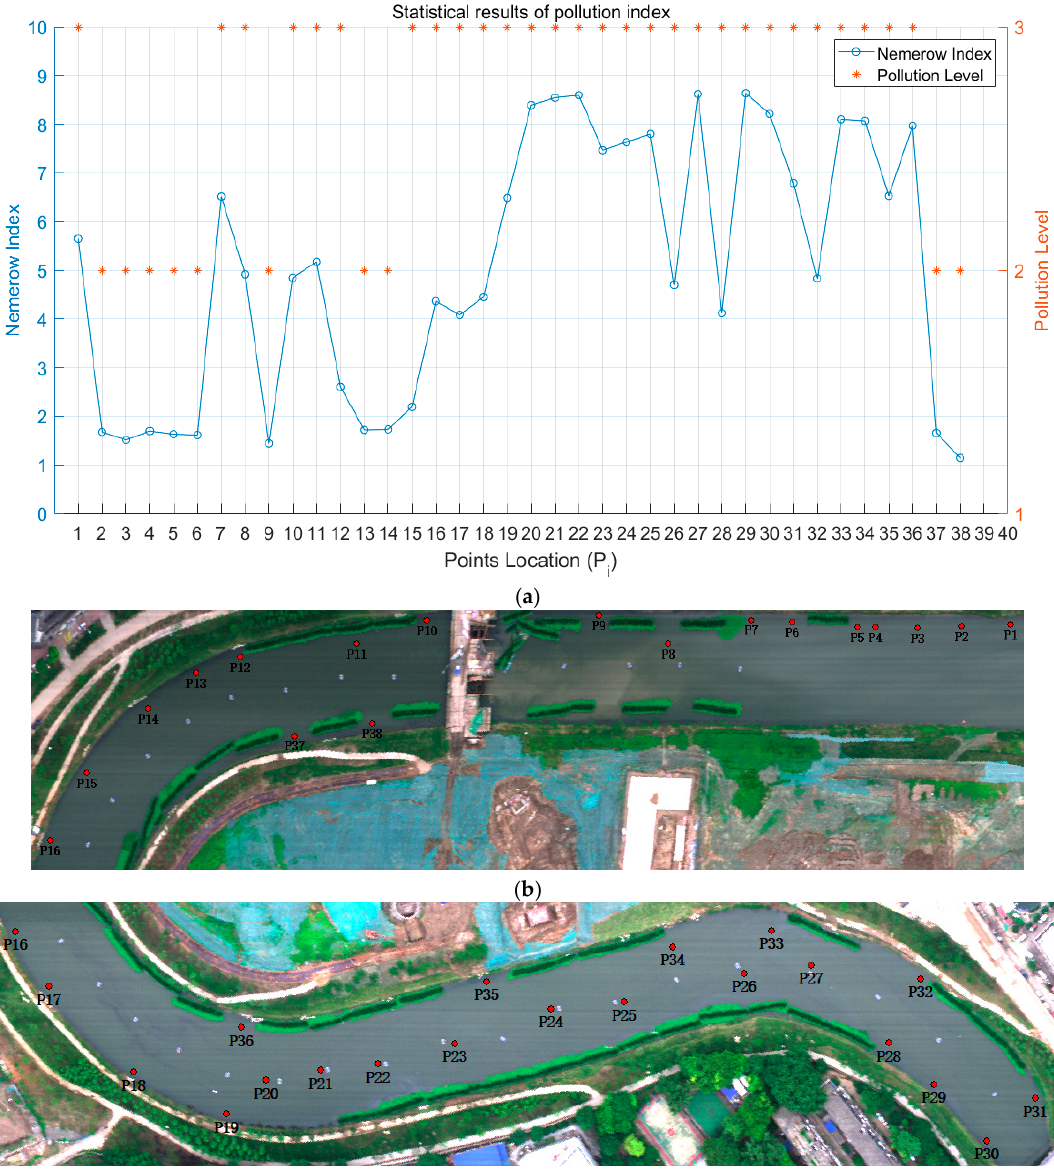
Figure 11. Statistical results of the pollution level and the Nemerow index for the Xunsi River dataset. ( a ) line chart; ( b ) spatial distribution of sampling points upstream; ( c ) spatial distribution of sampling points downstream.